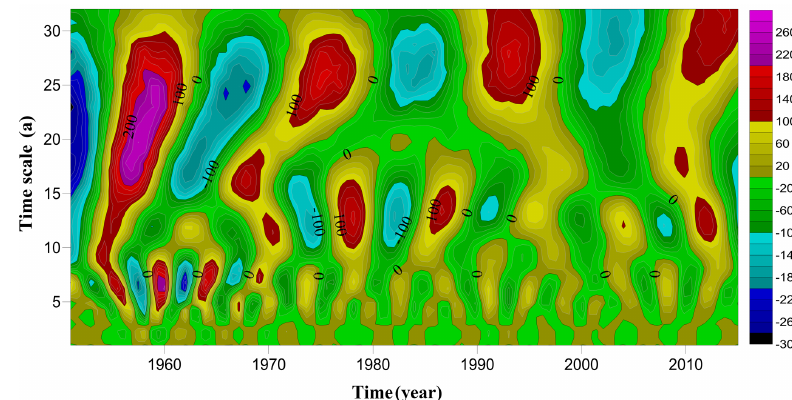
Figure 4. The real part distribution of wavelet